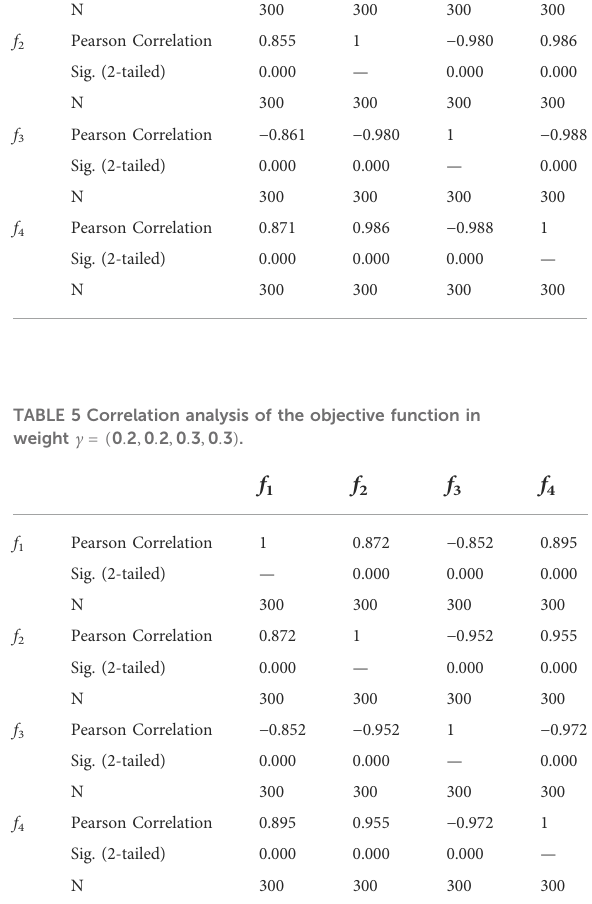
everywhere. Figure 3B: When DG is connected to node 25, the voltage fl uctuation of node 26 is relatively obvious, the voltage of node 53 fl uctuates slightly, and the voltage of the other two places has no fl uctuation. Figure 3C: When DG is connected to node 52, the voltage fl uctuation of node 53 is relatively signi fi cant, the voltage of node 26 fl uctuates slightly, and the voltage of the other two places has no fl uctuation. Figure 3D: When DG is connected to node 67, the voltage at node 68 fl uctuates slightly, while the voltage at other places does not fl uctuate.